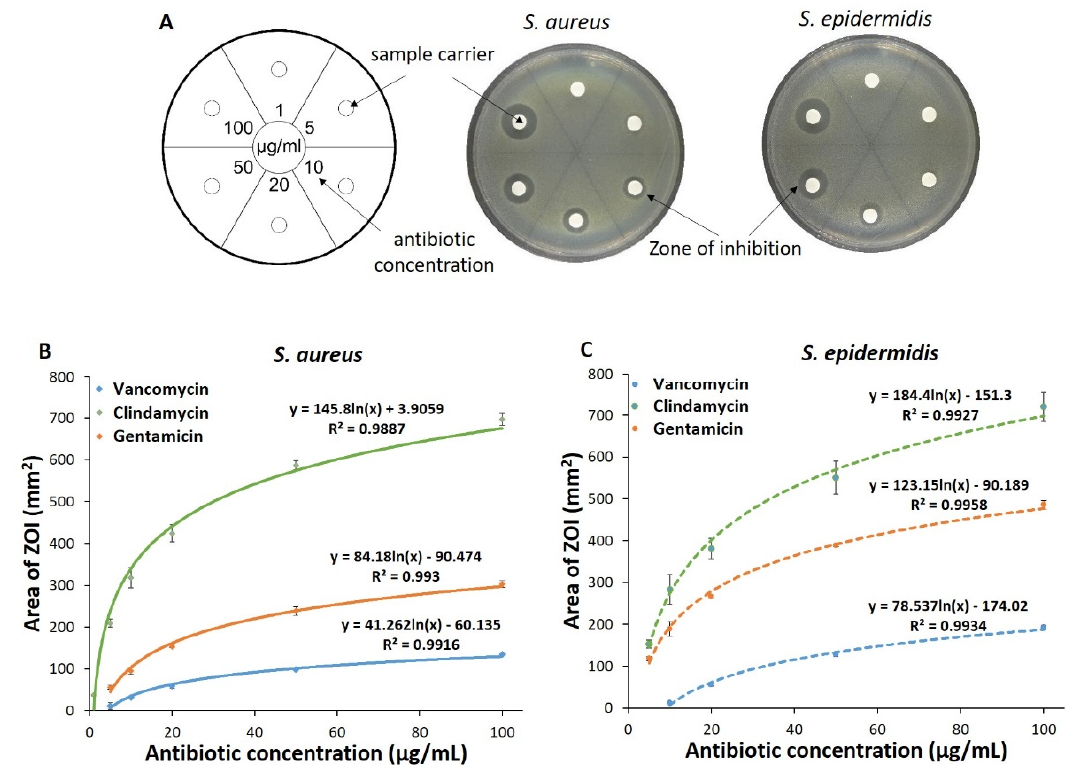
Figure 5. Adaptation of the agar diffusion test for quantification of antibiotics. A schematic diagram of an agar plate with sample carriers: Numbers in each sector indicate the concentration of antibiotic solution. Example images of the agar plates whose sample carriers were loaded with vancomycin, which led to formation of a clear area (ZOI) around the sample carriers ( A ). Standard curves of clindamycin, gentamicin and vancomycin obtained by plotting the area of ZOI developed on agar plates containing S. aureus ( B ) and S. epidermidis ( C ) vs. respective antibiotic concentration loaded on the sample carriers ( n = 3).